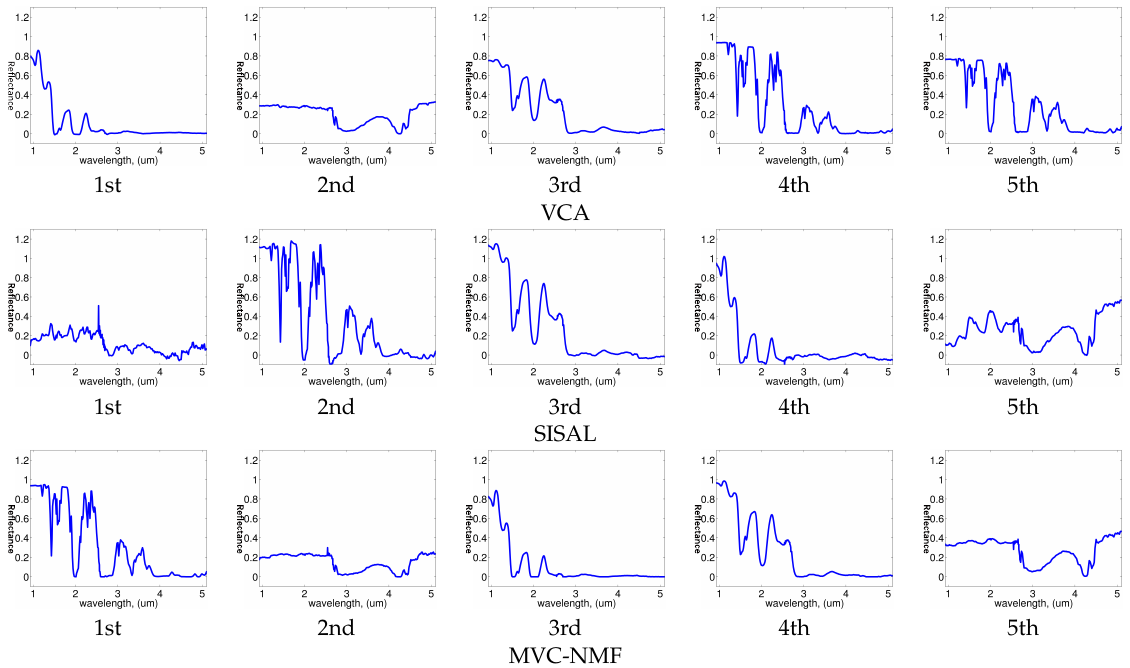
(Figure 4) with the reference spectra of the endmembers under different conditions (Figure 3) by computing the correlation coefficients between them. The coefficient values are shown in Table 7.